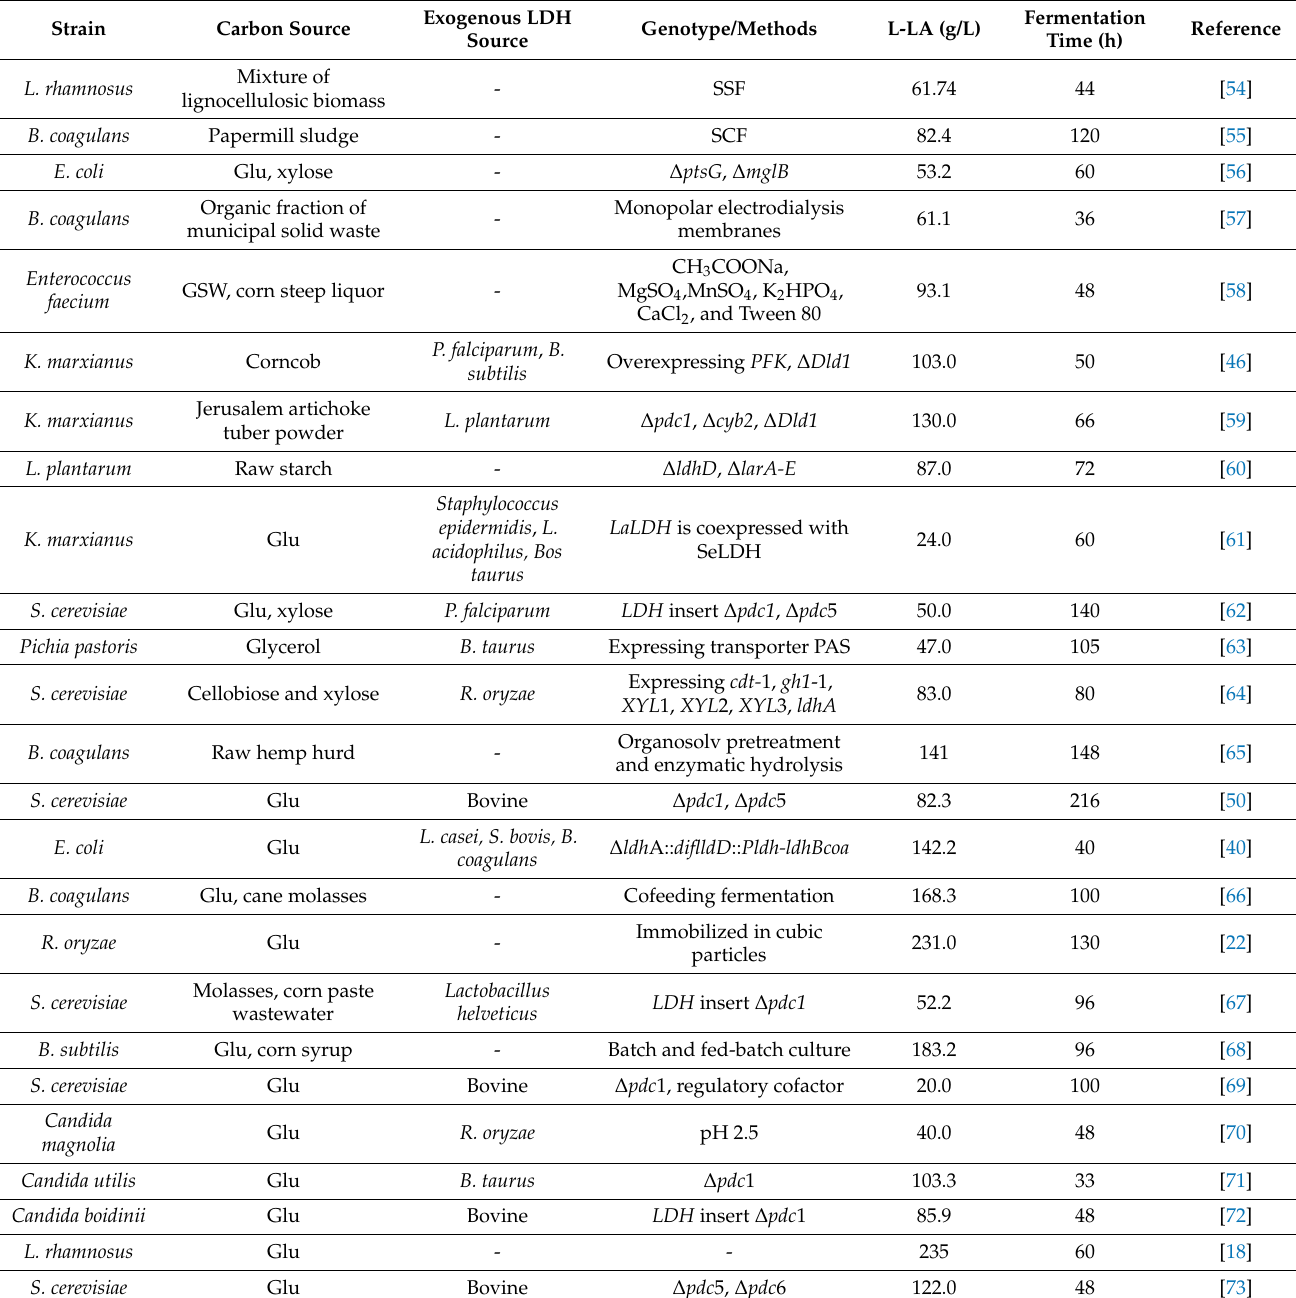
Table 2. Research status of L-LA production by genetically engineered